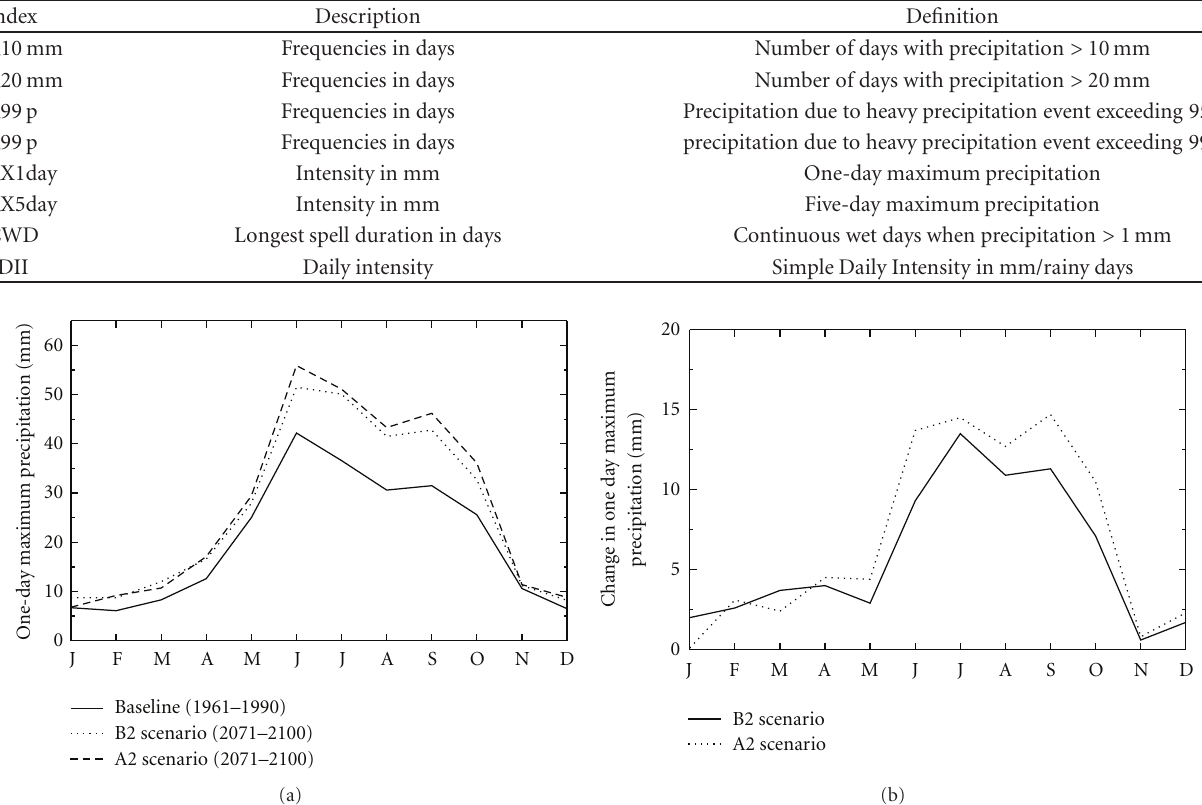
Figure 1: Monthly mean all-India one-day maximum precipitation in mm (RX1day, (a)) as simulated by baseline (1961–1990), A2 and B2 scenarios (2071–2100) and changes in one day maximum precipitation in A2 and B2 scenarios with respect to baseline